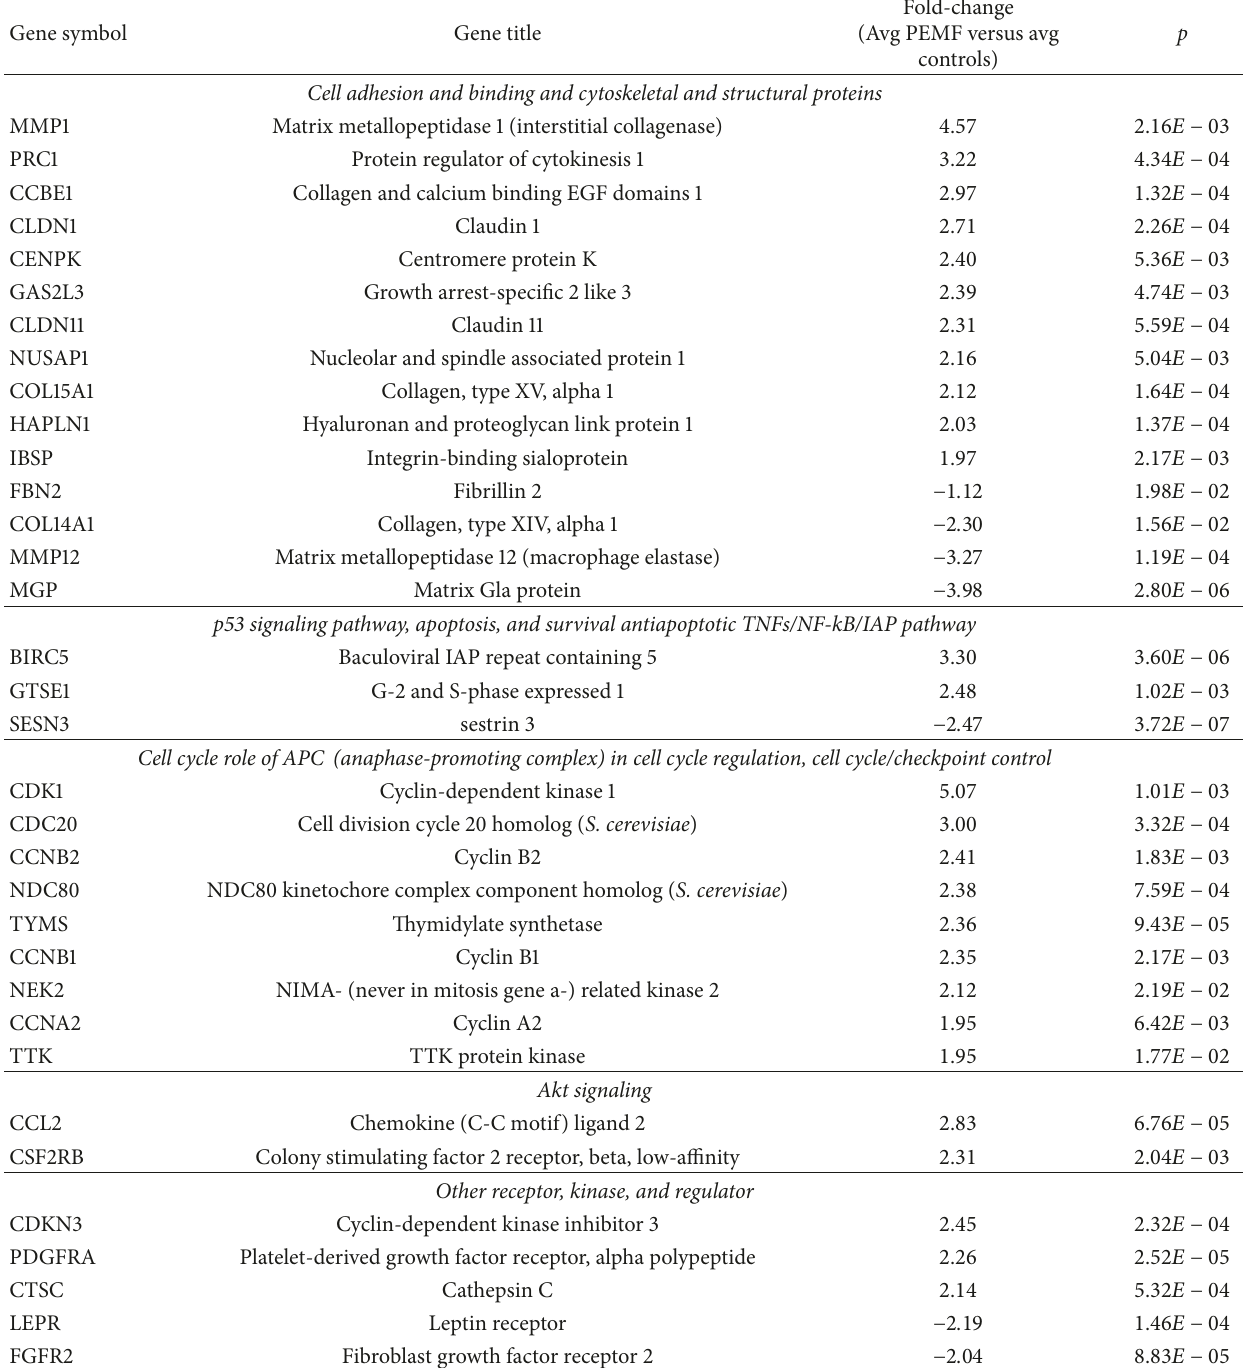
Table 2: Genes regulated by PEMF during hBMSCs proliferation by microarray analysis. Cells were from a normal 27-year-old female. Total RNA was isolated at day 5 after 2 h of PEMF treatment and used for microarray assays as described in Materials and Methods. Analysis by Student’s 𝑡